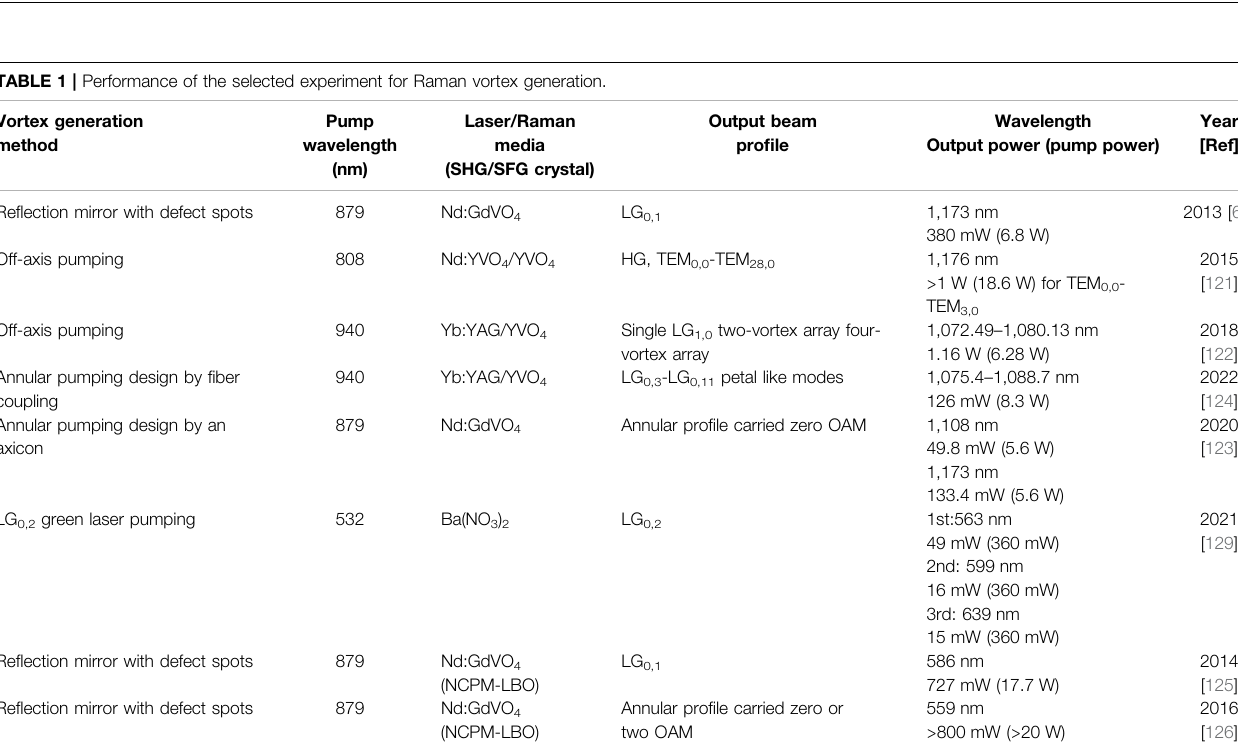
FIGURE 9 | Forked interference fringes of (A) 1,173 nm Stokes fi elds and (B) SHG of the fi rst Stokes (1,173 nm) for 586-nm yellow beam [125].